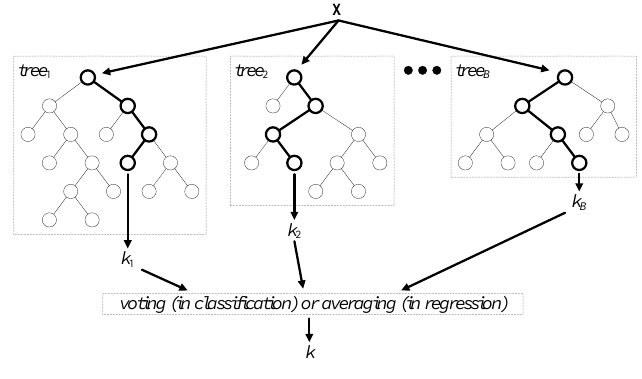
Figure 6. Architecture of the random forest